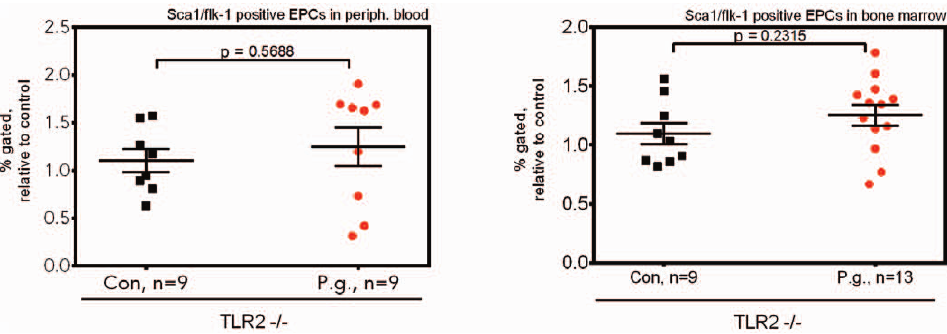
Figure 7. Sca1 + /flk1 + progenitor mobilization is TLR2-dependent. In mice deficient in toll-like receptor (TLR)-2, the receptor primarily mediating the invasion of P. gingivalis into host cells, no increased mobilization of Sca1 + /flk1 + progenitors was observed. Data are presented as mean percentages of gated cells 6 SEM normalized to control, statistical testing was performed using unpaired t-tests.